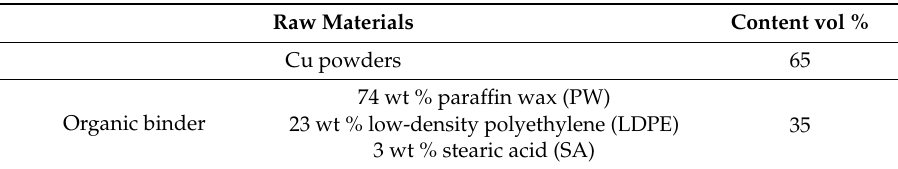
Table 1. Composition of the raw